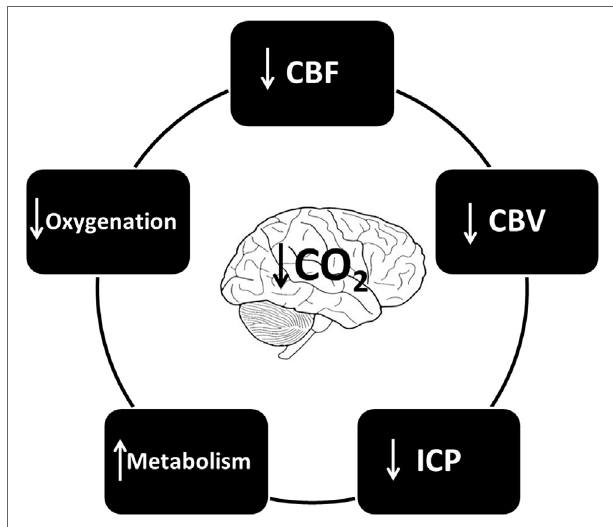
FiGURe 3 | The cerebral effects of